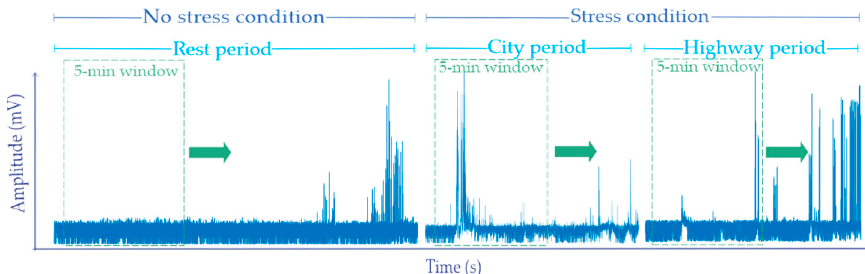
Figure 4. Extracted EMG signal segments for each scenario.